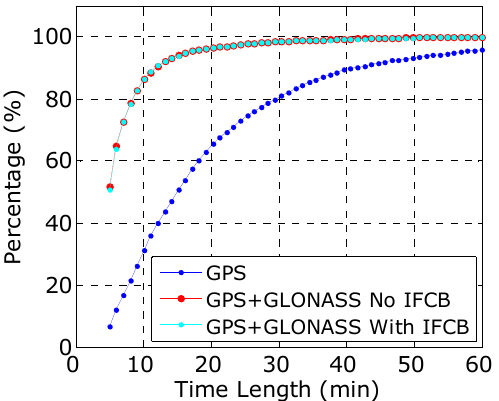
Figure 15. Fixing percentage for various observation durations for kinematic PPP with different strategies for base station.